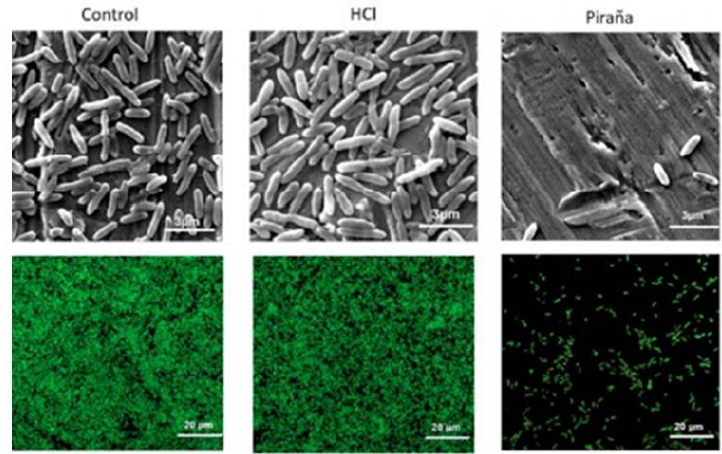
Figure 10. SEM ( top row ) and fluorescence ( bottom row ) images of P. aeruginosa stained by LIVE/DEAD.